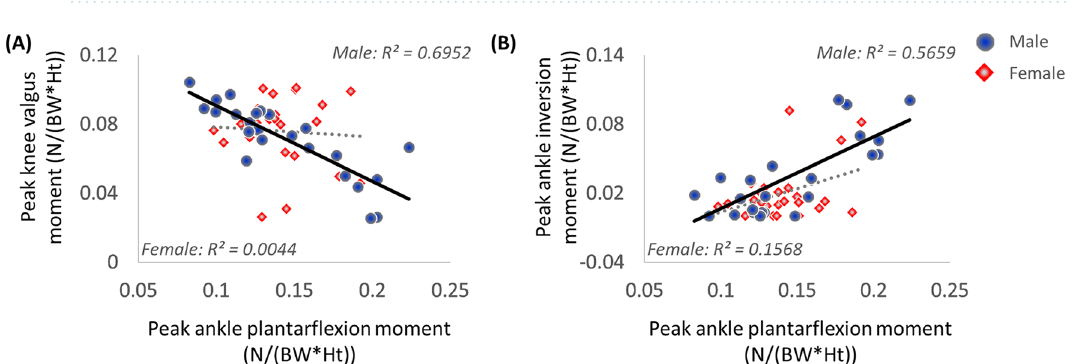
Figure 2. Scatter plots depicting the relationship between: ( A ) peak ankle plantarflexion and peak knee valgus moments and ( B ) peak ankle plantarflexion and inversion